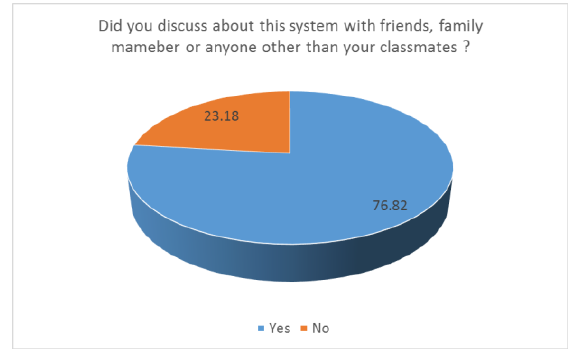
Figure 5. Results of question 5.